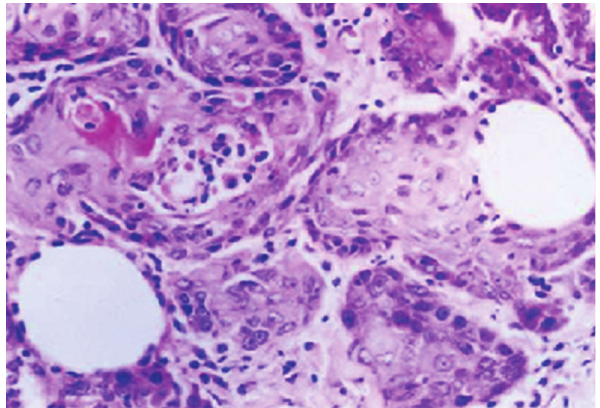
Figure 1: The lung cancer specimen induced by MCA, showing that the carcinoma cells formed nests in which the red horny pearl was obvious; carcinoma cell nucleus were very big and vacuous, and nucleoli were big and localized to the edge. HE ×